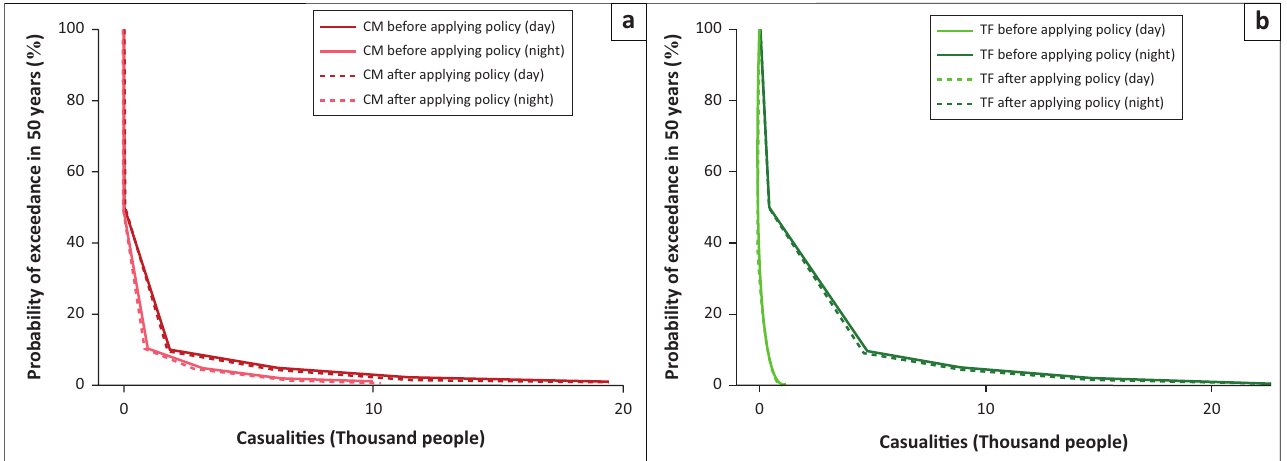
FIGURE 12: Risk curves in terms of number of casualties for (a) confined masonry (b) timber frame before and after applying policy.